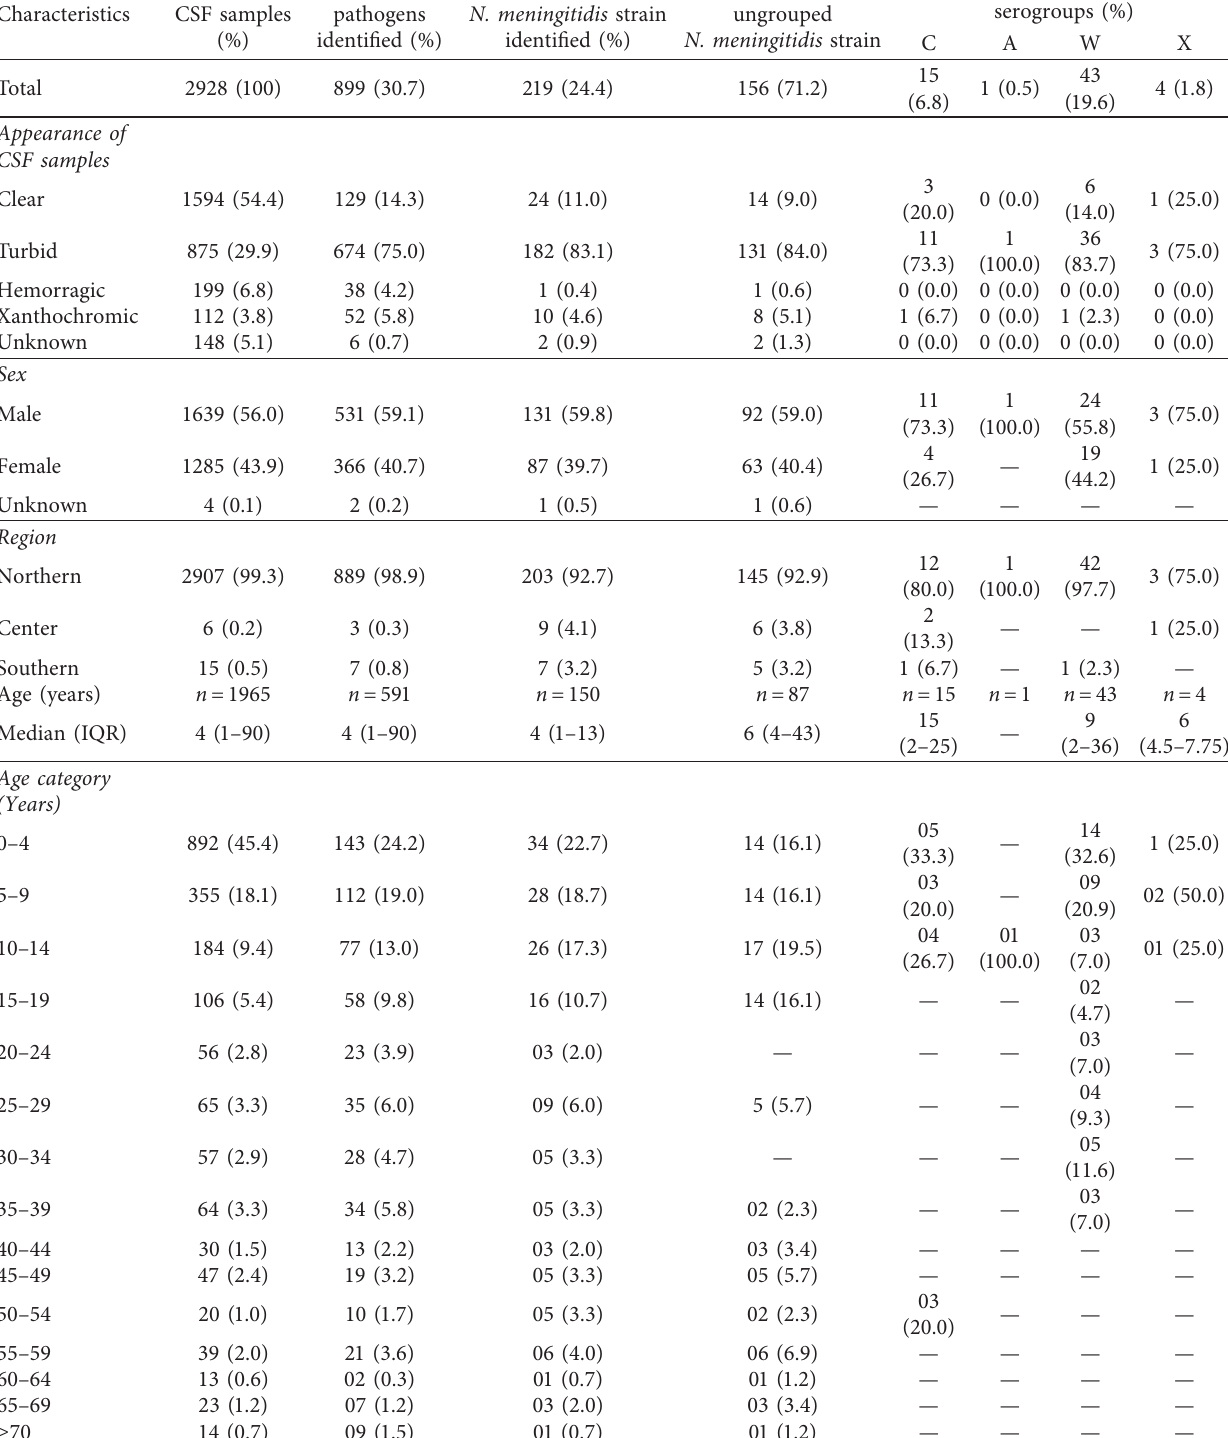
Table 1: Frequencies of N. meningitidis serogroups stratified by the geographic region, age, appearance of CSF samples, and sex in the Benin republic,